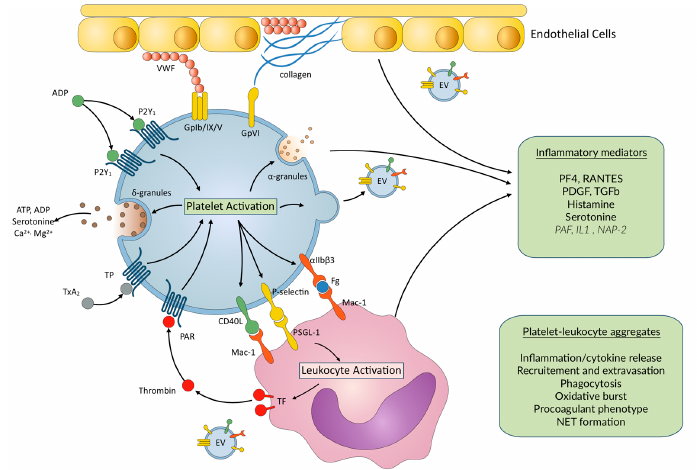
Figure 1. Main platelet–leukocyte interactions and inflammatory mediators released upon platelet activation. EC—endothelial cells; EV—extracellular vesicles; IL1—Interleukin 1; NAP-2—Neutrophil Activating Peptide-2; NET—neutrophil extracellular trap; PAF—platelet activating factor; PAR— protease activated receptor; PF4—platelet factor 4; PDGF—Platelet Derived Growth factor; TF— Tissue factor; TGF β —Transforming Growth Factor β . VWF—von Willebrand factor. Mediators are stored in platelets. In italics—synthetized mediators/proteolytic cleavage of stored precursors upon platelet activation.